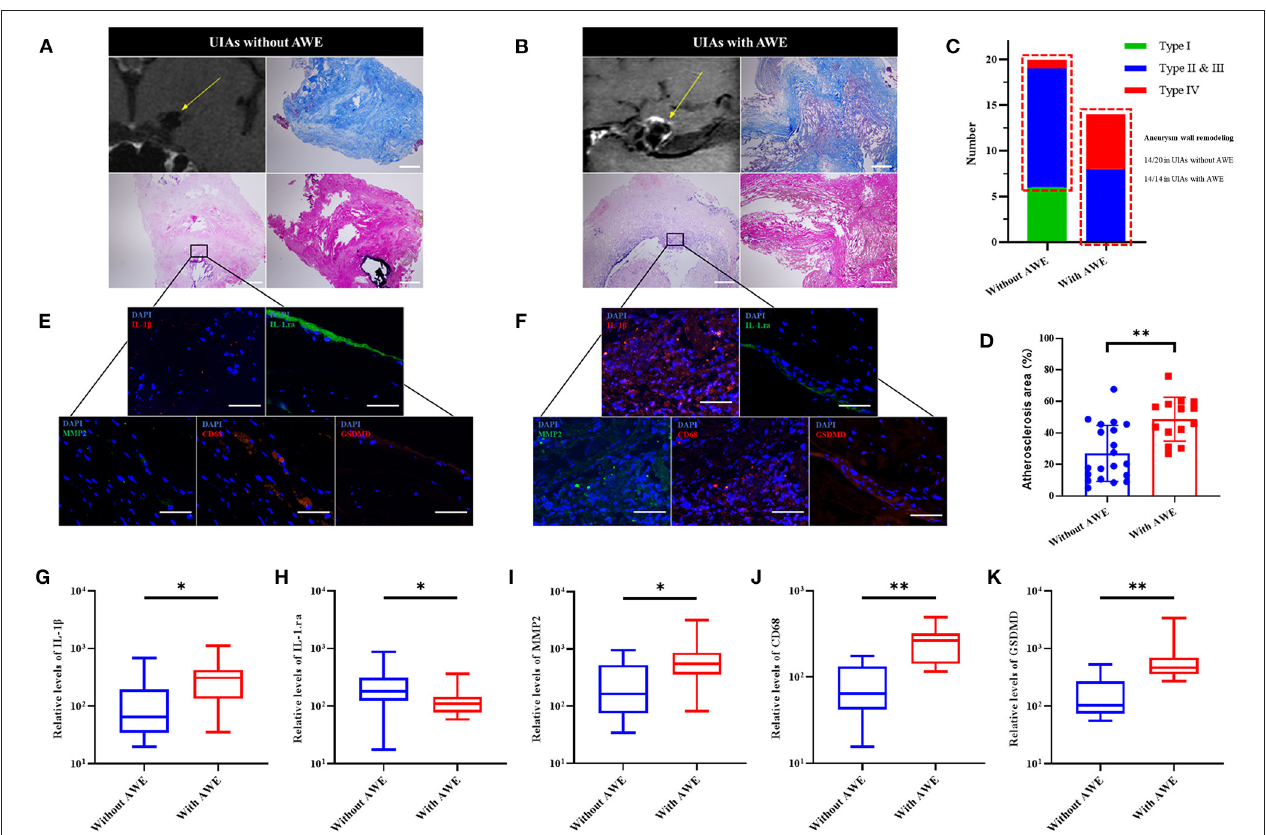
FIGURE 3 | The GSDMD and the inflammatory factors in UIAs with and without AWE. (A,B) Two representative cases of histological analysis for UIAs with and without AWE. The H-E staining indicated a severe wall remodeling and inflammation infiltration in the UIAs with AWE. The Masson staining showed that atherosclerosis was more significantly changed in the UIAs with AWE. The EVG staining reported the reduced elastic fibers in the UIAs with and without AWE. The scale bar corresponded to 100 µ m. (C) The histograms of aneurysm wall remodeling between UIAs with and without AWE. Thus, it was known that all UIAs with AWE were manifested as significant wall remodeling (type II & III, or type IV). The red box indicated the number of aneurysm wall remodeling. (D) The atherosclerosis area between UIAs with and without AWE. The UIAs with AWE had a larger atherosclerosis area compared with UIAs without AWE. (E,F) The IL-1 β , IL-1.ra, GSDMD, CD68 and MMP2 in UIA tissues were detected in this study. The scale bar corresponding to 40 µ m. (G–K) The box plot of the relative levels of IL-1 β , IL-1.ra, MMP2, CD68 and GSDMD for UIAs with and without AWE. * P < 0.05; ** P < 0.01. UIA, unruptured intracranial aneurysm; AWE, aneurysm wall enhancement; GSDMD, gasdermin D; MMP2,